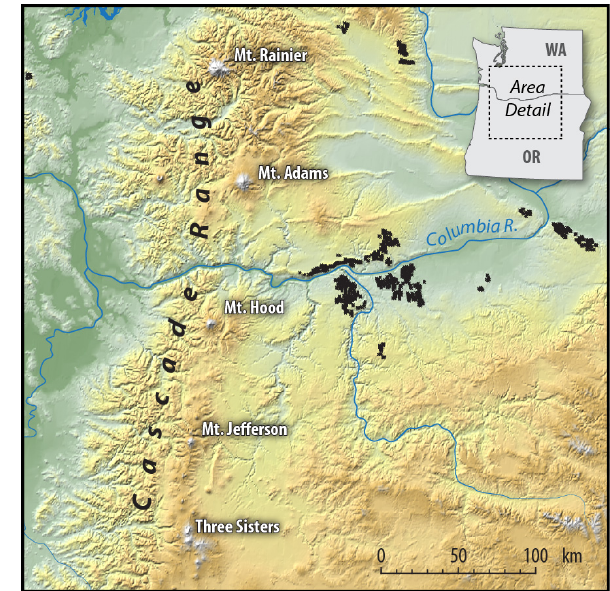
Figure 1. Map with the location of the major volcanoes (white labels) and wind farms (black dots) in the area. Figure by Billy Roberts, National Renewable Energy